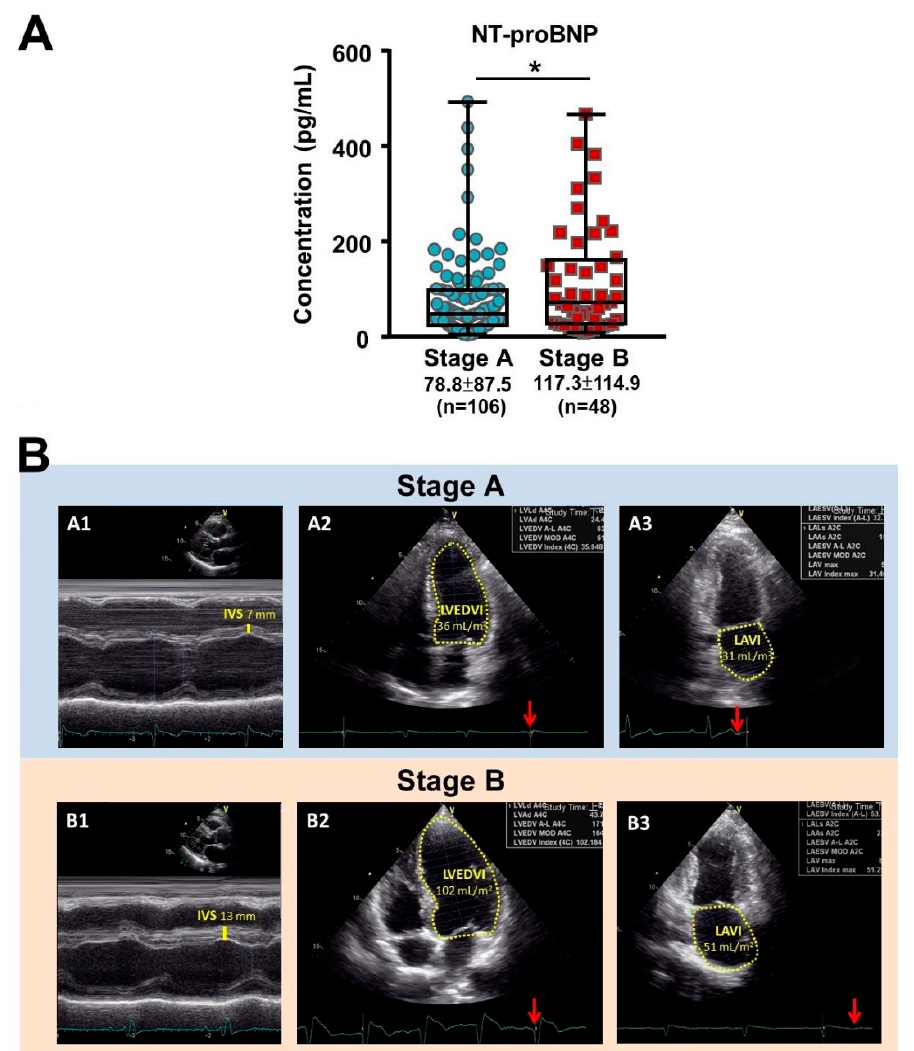
Figure 1. Representative echocardiographic images and the NT-proBNP levels of subjects in Stage A and B heart failure (HF). ( A ) The NT-proBNP levels of the subjects in Stage A and B HF. * indicated p < 0.05 by independent t -test. ( B ) Upper panel: a 68-year-old male subject with Stage A HF (body surface area (BSA) of 1.8 m 2 ). His echocardiographic parameters, including interventricular septum thickness (IVS; A1, 7 mm, normal range 6–10 mm), left ventricle end diastolic volume index (LVEDVI; A2, 36 mL/m 2 ; normal range < 95 mL/m 2 ), and left atrium volume index (LAVI; A3, 31